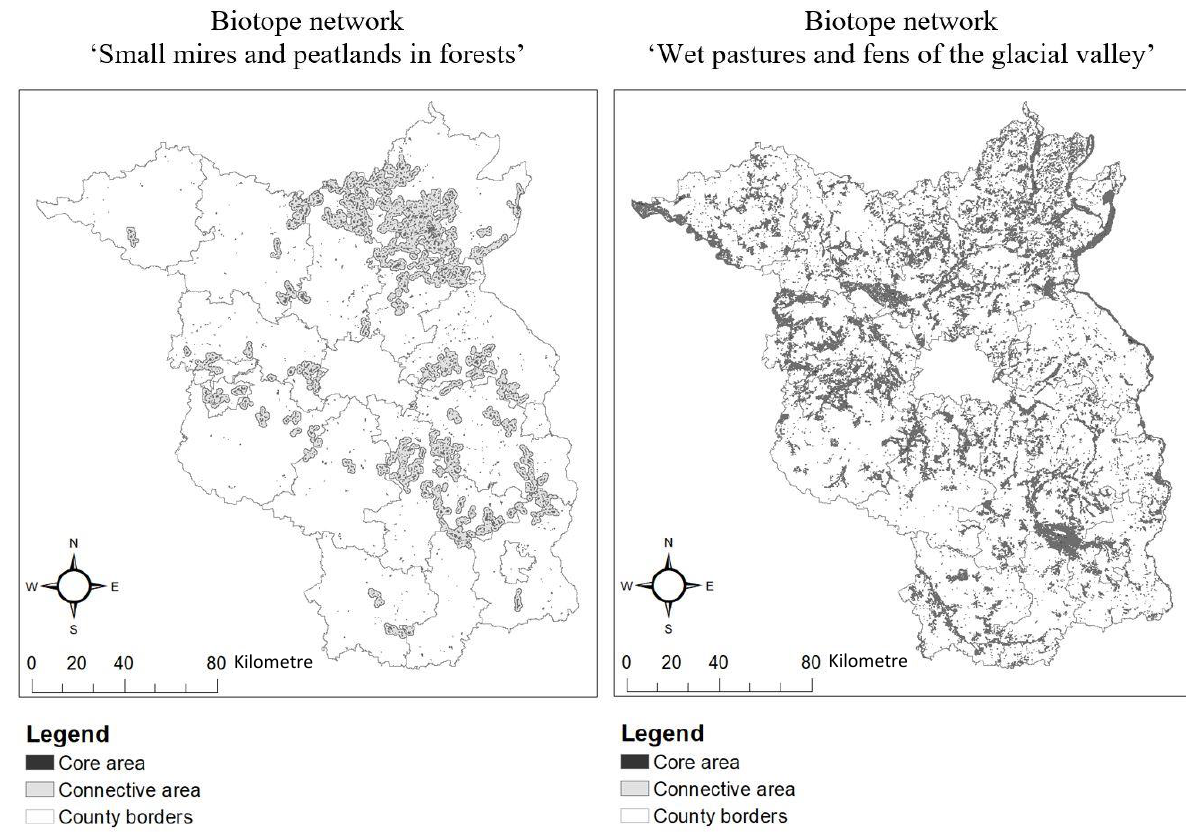
Figure 2. Biotope network of peatlands in Brandenburg, north-east Germany (Herrmann et al. 2013).